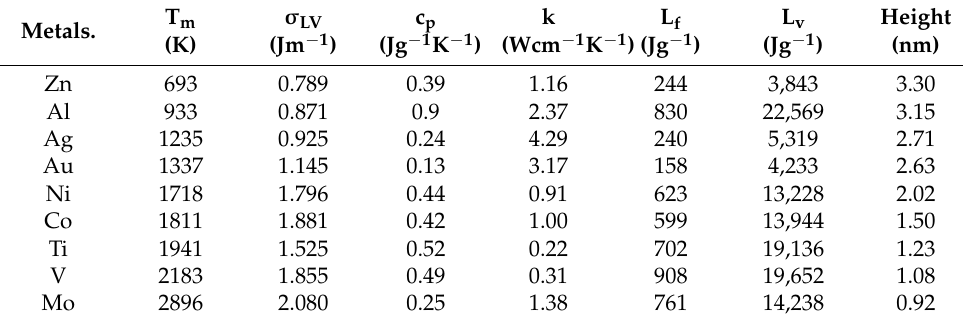
Table 1. Metal properties and experimental data